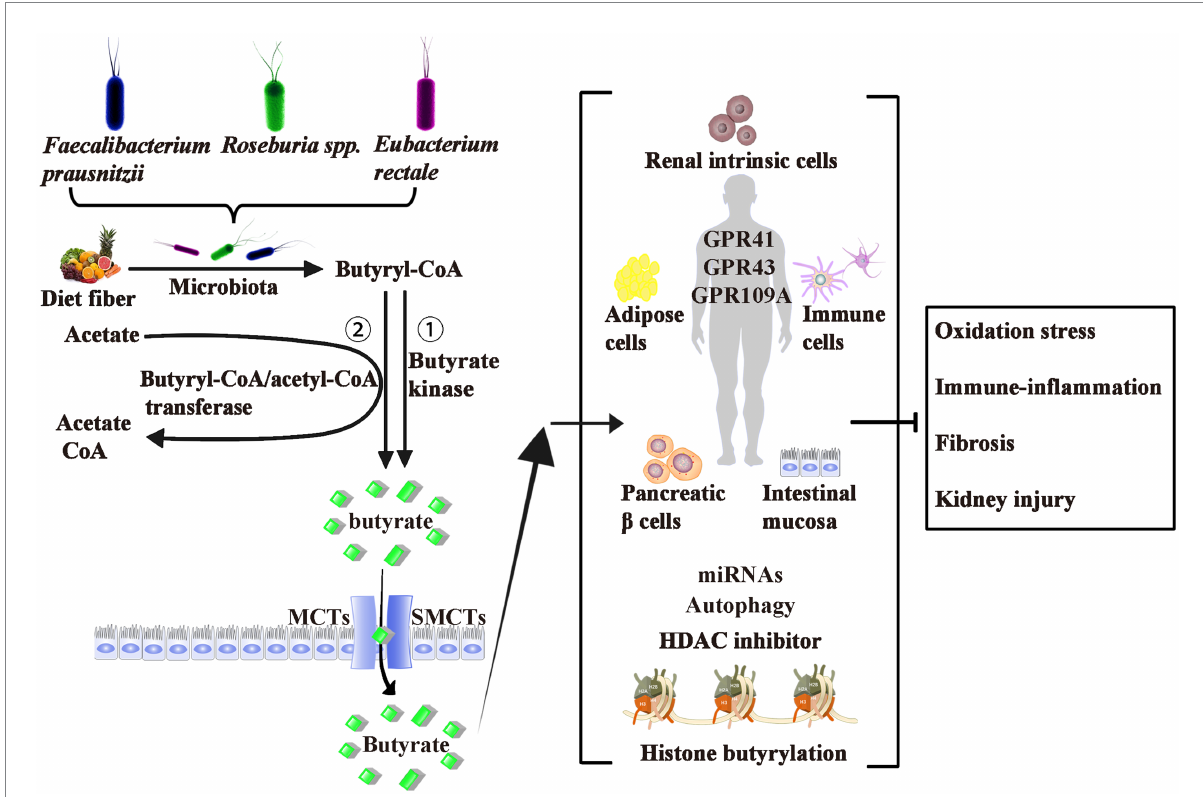
FIGURE 1 Origin, Production, Transport, Effects, and Mechanism of Butyrate. Butyrate is produced from dietary fiber by bacterial fermentation through two metabolic pathways: (1) butyryl-CoA is transformed to butyrate via butyrate kinase and (2) the CoA moiety of butyryl-CoA is transferred to butyrate and acetyl-CoA via butyryl-CoA: acetate CoA-transferase. The two most important butyrate-producing bacteria are Faecalibacterium prausnitzii and Eubacterium rectale/Roseburia spp. Butyrate is absorbed by colonic epithelial cells as energy sources mainly through MCTs and SMCTs. About three of the de-orphanized GPCRs (GPR41, GPR43, and GPR109A) have been identified as butyrate receptors in the human intestinal mucosa, renal intrinsic cells, immune cells, pancreatic β cells, and adipose tissues. Butyrate act as epigenetic regulators by the inhibition of HDAC, the upregulation of miRNAs, or induction of the histone butyrylation and autophagy. Although controversial, most studies believe that exogenous or endogenous butyrate improves inhibits oxidative stress, and ameliorates diabetic inflammation. GPCRs, G-protein coupled receptors;